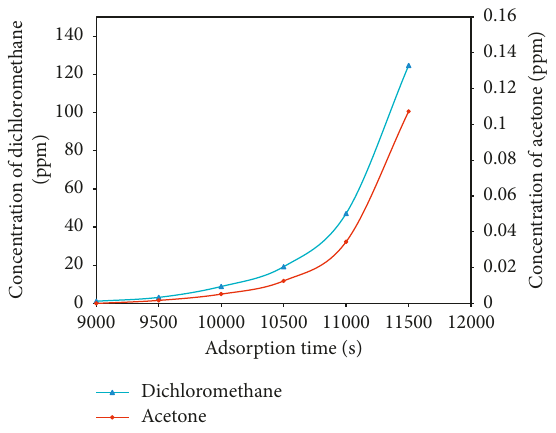
Figure 14: Maximum concentration of dichloromethane and ac- etone at the end the adsorption step for